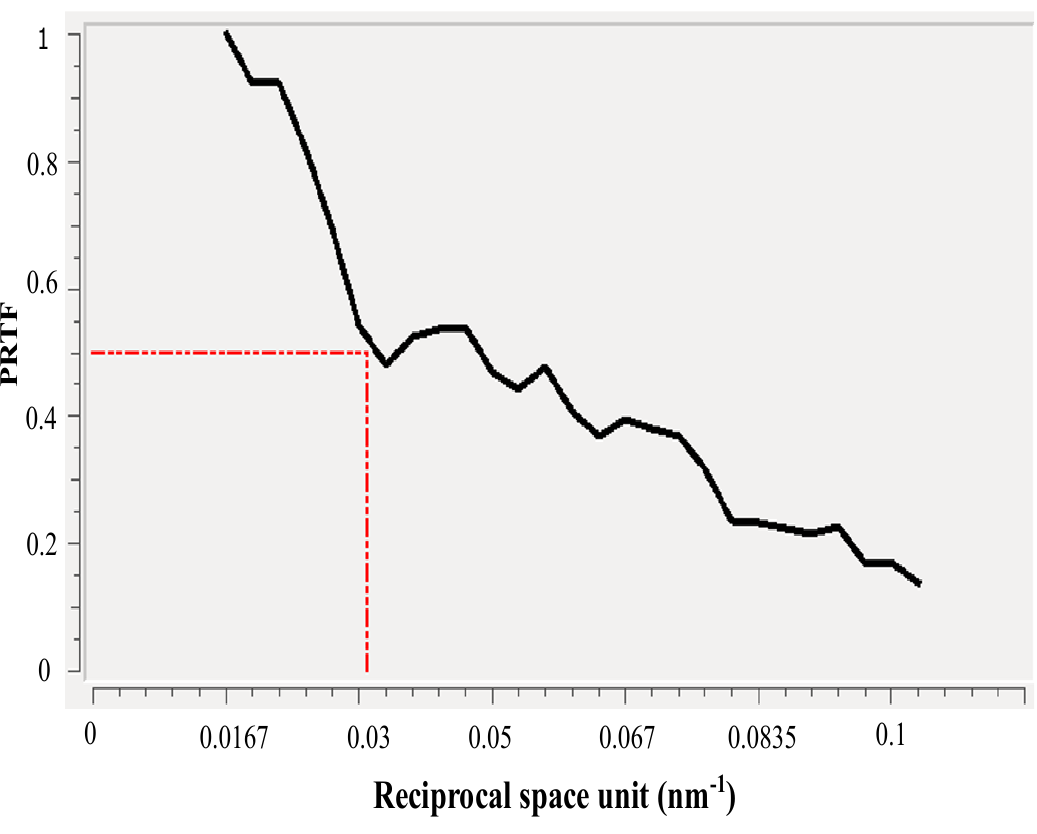
Figure 4. Resolution estimation by phase retrieval transfer function (PRTF). The phase retrieval transfer function is a tool that provides an accurate resolution measure. It takes a value of 1 where the iterative algorithm produced perfect convergence consistently, and a value near 0 where the algorithm continually failed to converge. Dashed line on the graph shows 50% cutoff frequency which is used to estimate the threshold of resolution reliability, which for our Bragg coherent diffraction imaging (BCDI) experiment is approximately 30 nm in Figures 2 and